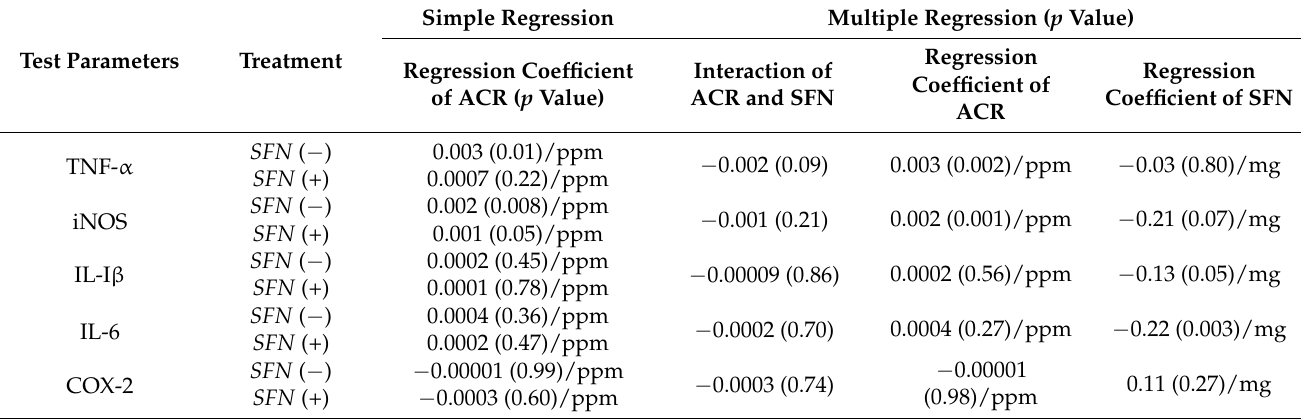
Table 4. Results of regression analysis for the effects of acrylamide and sulforaphane on mRNA expression of pro- inflammatory cytokines in the cerebral cortex.